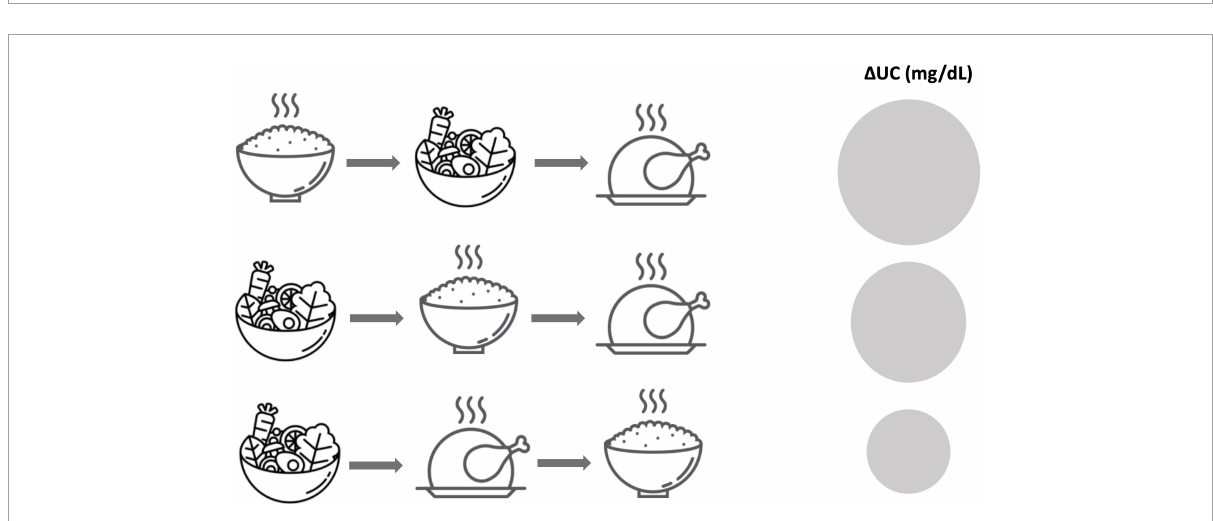
FIGURE2 The order of consumption of different food groups has a different impact on the AUC. A significant decrease in AUC (mg/dl) is observed when starchy foods are consumed last, after fiber, fat, and protein. In this figure, adapted from Nishino et al. (58), AUC is represented with a circumference, being larger when the AUC is